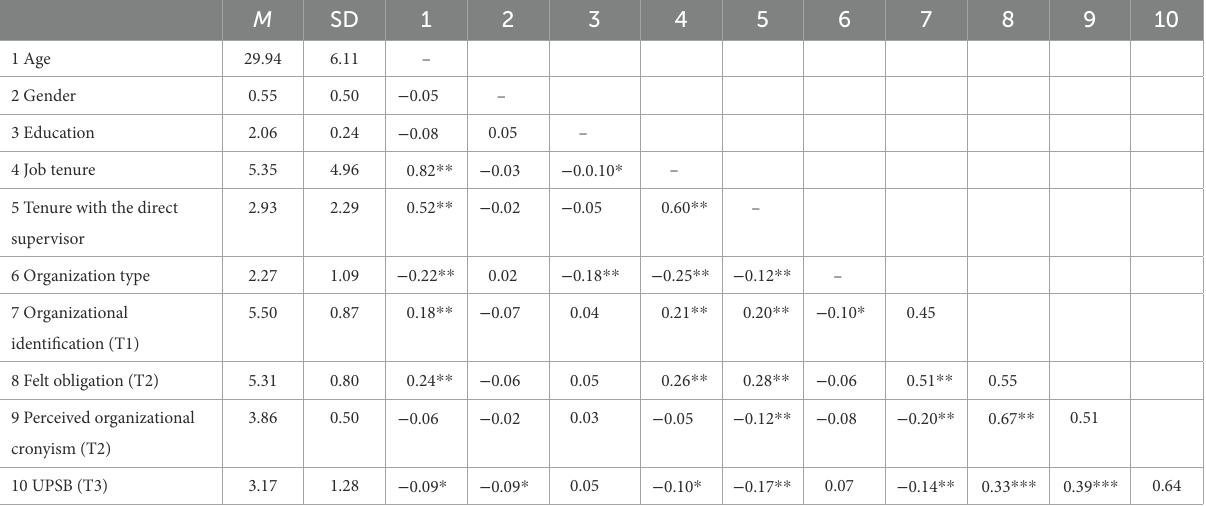
TABLE 2 Variable mean, standard deviation, and correlation